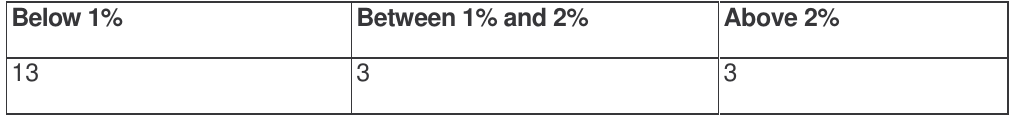
Table 1: Percentage representation of people with disabilities Below 1% Between 1% and